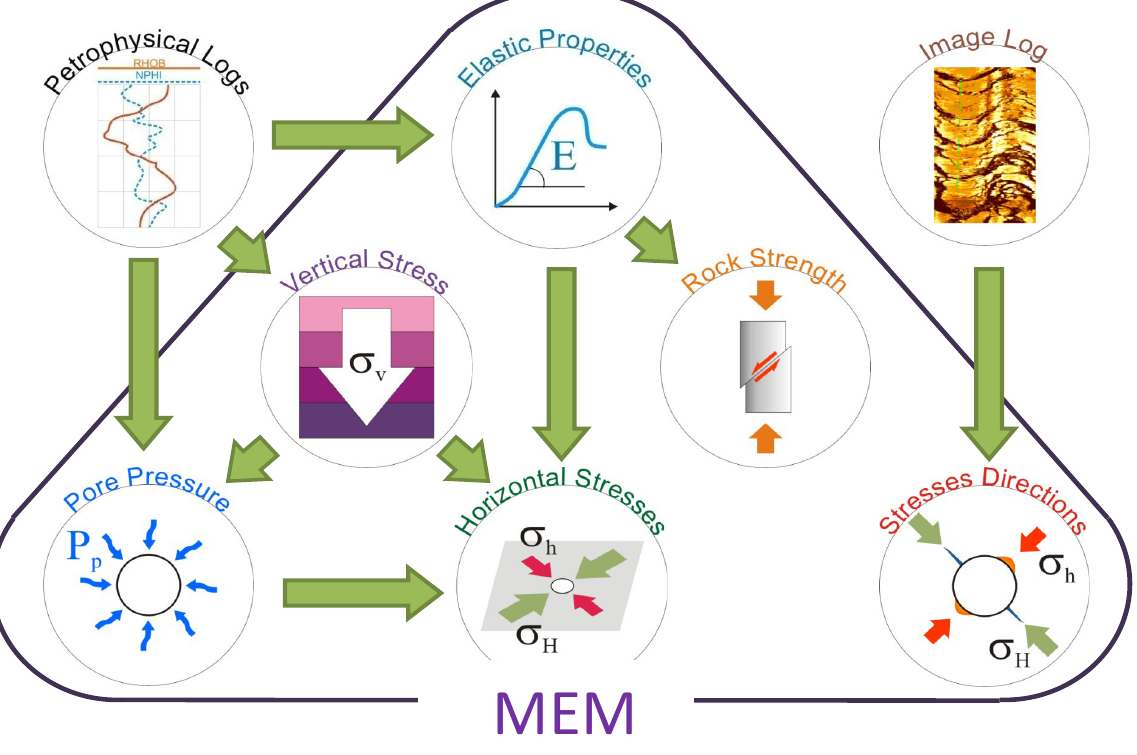
Figure 2. Constructing the Mechanical Earth Model (MEM) to find rock elastic moduli and strength and in-situ horizontal and vertical stresses.